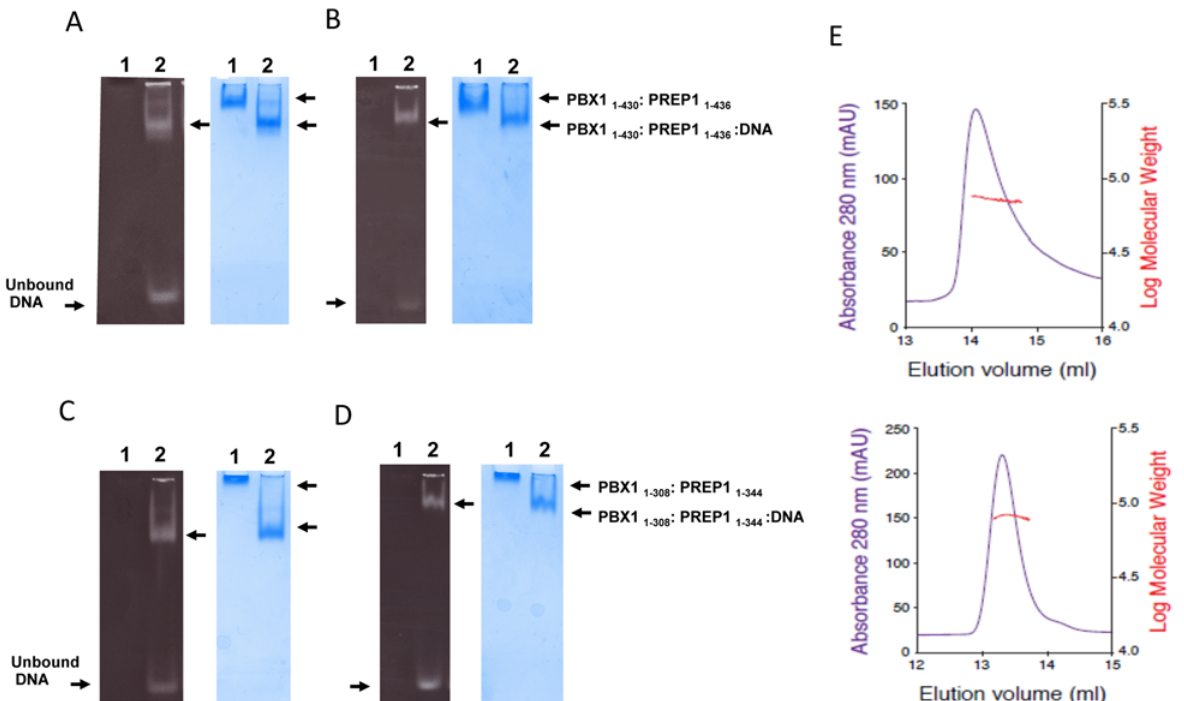
Fig 6. DNA binding of purified recombinant PBX1:PREP1 complexes. A and B. EMSA of PBX1:PREP1 complex binding to O1 oligonucleotides. Co- purified full-length PBX1:PREP1 complex (2.5 μ M) was incubated in the presence of 1 μ g of poly(dIdC) at 1:1 molar ratio with a 22 bp DNA fragment (Panel A) or an 11 bp DNA fragment (Panel B) for 30 minutes at 4°C before loading on gel (Lanes 2). The sequences of DNA are reported in Table 2. As a reference the complex without DNA was also loaded on gel (Lanes 1). Note that with the 22 bp oligo (Panel B) at the highest ratios an additional upper band is visible, possibly corresponding to the binding of a second PREP1:PREP1 complex to the DNA. C and D. EMSA of PBX1 1 – 308 :PREP1 1 – 344 :DNA complex. Co- purified PBX1 1 – 308 :PREP1 1 – 344 complex (2.5 μ M) was incubated in the presence of 1 μ g of poly(dIdC) at 1:1 molar ratio with the 22 bp (Panel C) or the 11 bp DNA fragment (Panel D) for 30 minutes at 4°C before loading on gels (Lanes 2). In Lanes 1 were loaded the protein complexes without DNA. E. Static